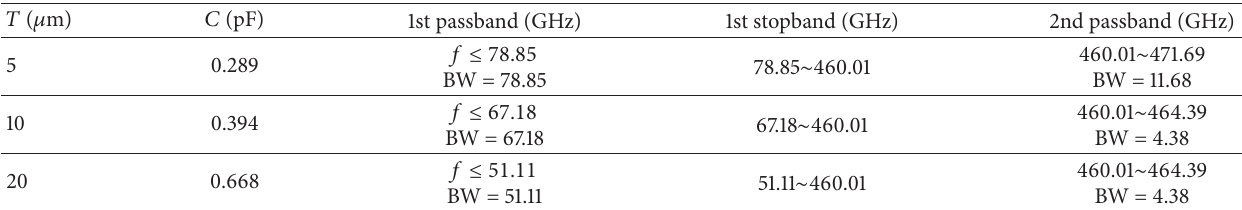
Table 2: Passband and Stopband of The